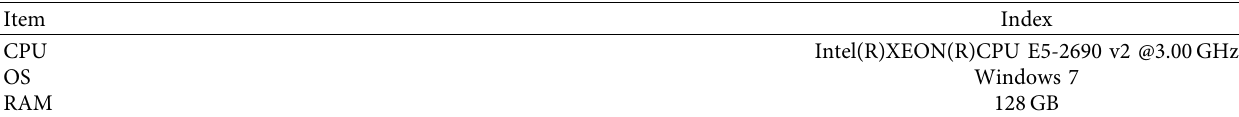
Figure 13: Finite elements of the structure and interior fuids in the FE-FE-BE method. Table 2: Te confgurations of computer used in this